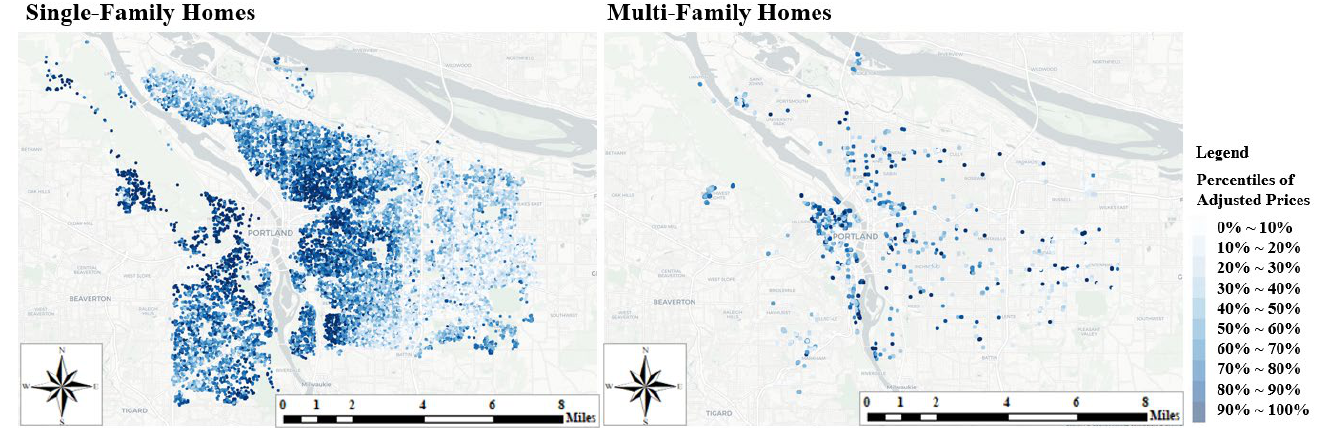
Figure 4. Distribution of observations and their inflation-adjusted house prices (Data Source: Regional Land Information